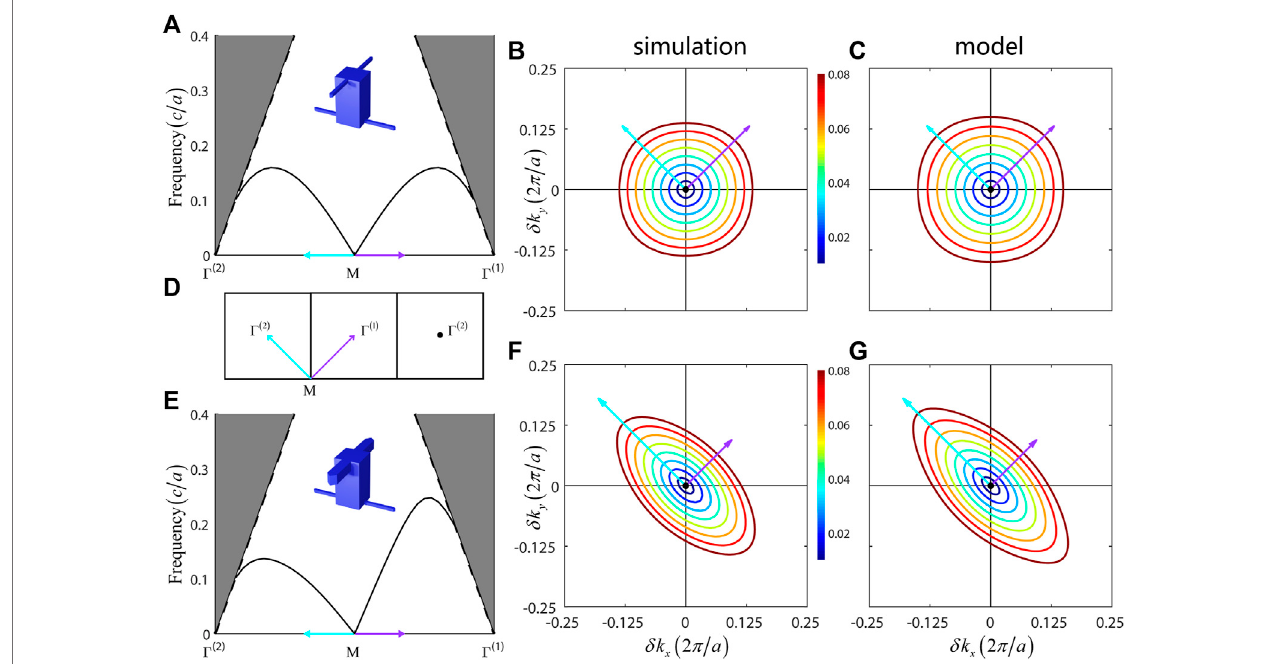
FIGURE 5 | Shaping the index ellipsoids by introducing anisotropic inductances. (A) Simulated band dispersion and (B) corresponding IFCs for the isotropic MM shown in Figure 2A . In this case, the two metallic wires have the same bar width (height d = 0.8 a , width w p = 0.4 a , and w ^ u inductances along ^ u 1 and ^ u 2 directions. (C) IFCs given by the equivalent circuit model. When the frequency increases, the index circle gradually evolves into a squircle shape,whichagreeswellwiththesimulatedresultinpanelB. (D) FirstandsecondBrillouinzones. (E) Simulatedbanddispersionand (F) correspondingIFCsforan anisotropic metamaterial. In this case, the metallic wire in the ^ u 1 direction has a thicker bar width than the one in the ^ u 2 direction (height d = 0.8 a , width w p = 0.4 a , (cid:2) 0 . 4 a , and w ^ (cid:2) 0 . 05 a ), leading to anisotropic inductances and the index ellipse in panel F. (G) IFCs given by the equivalent circuit model. w ^ u u 2 1